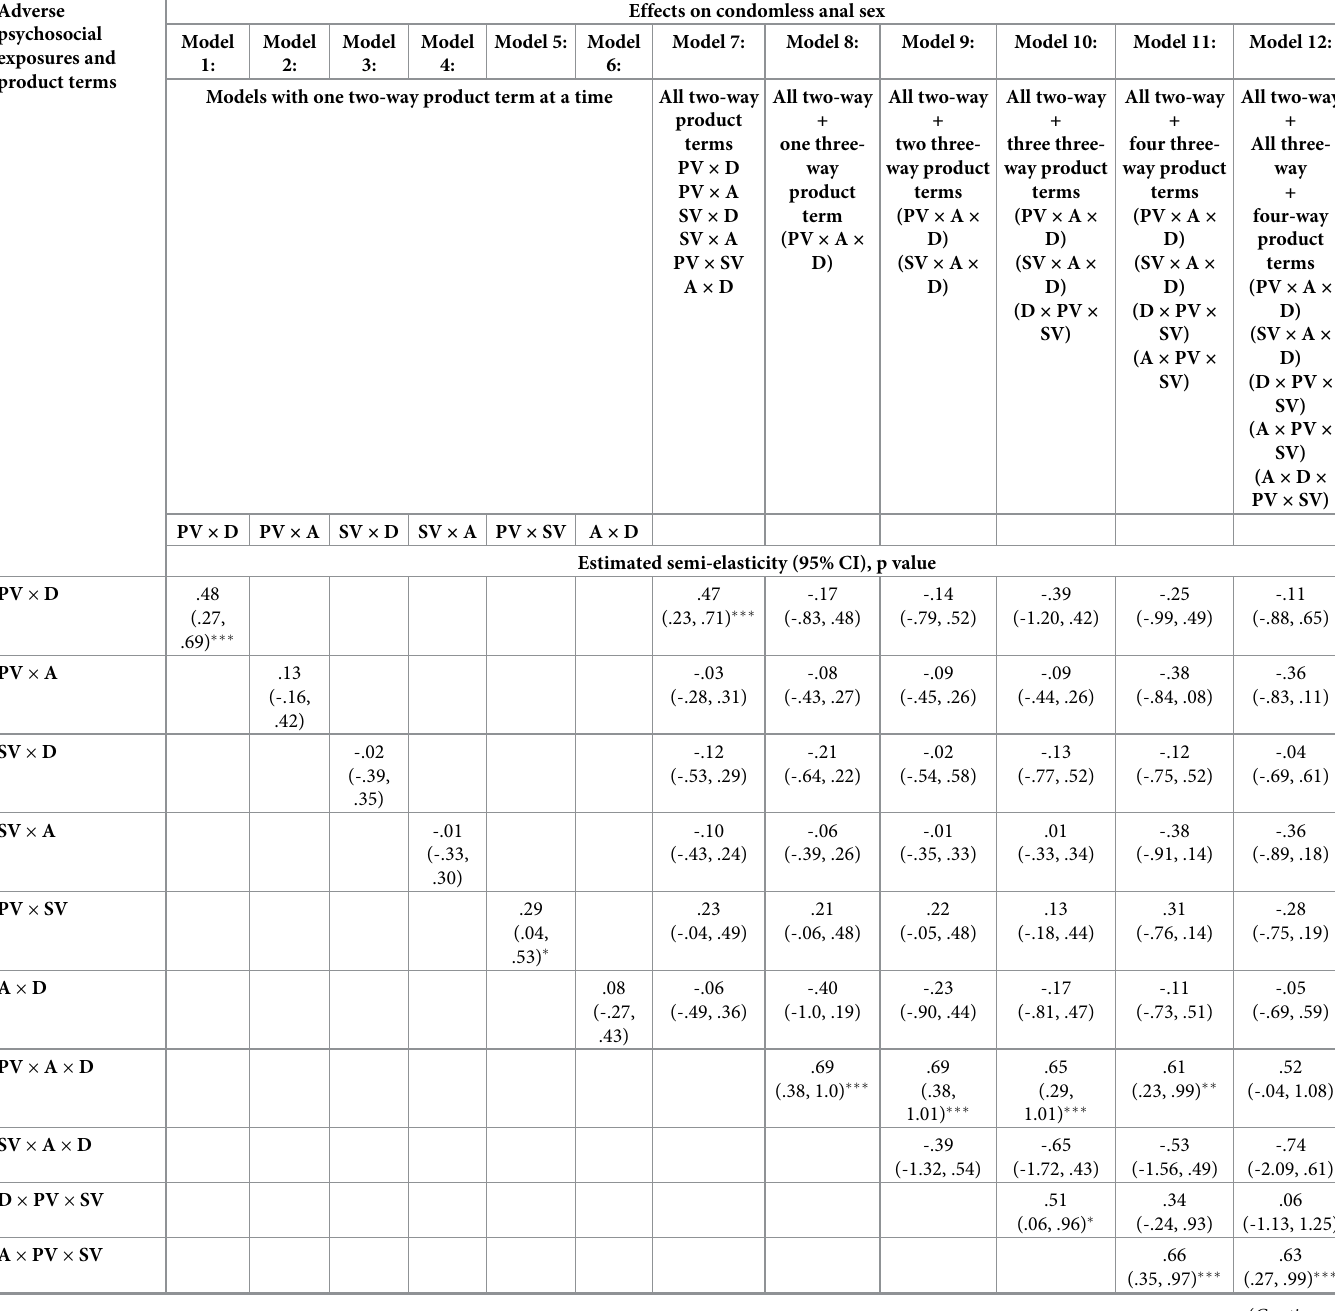
Table 4. Effect of adverse psychosocial exposures on condomless anal sex with male partners among HIV-negative transgender women: Measures of multiplicative Two-/Three-/Four-way interactions between physical violence, sexual violence, drug use, and frequent alcohol use (N = 4,607). Adverse